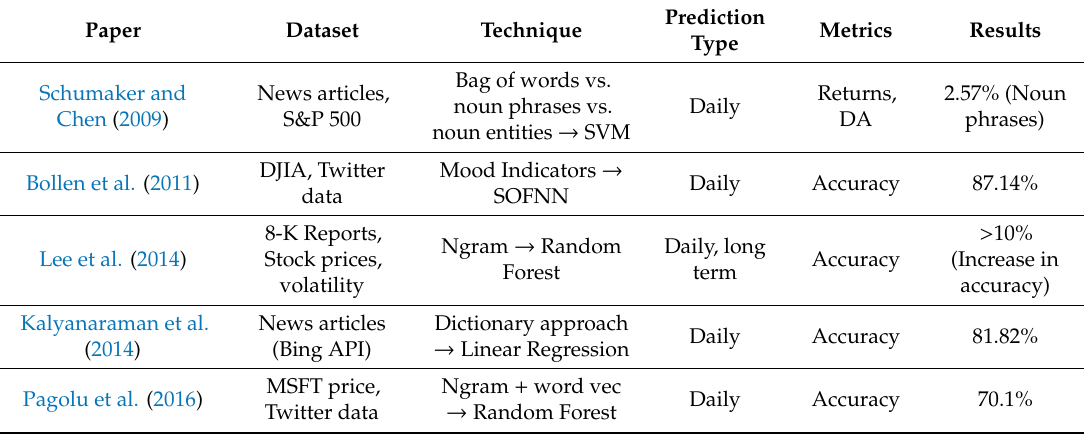
Table 2. Summary of literature on sentiment analysis approaches applied to stock